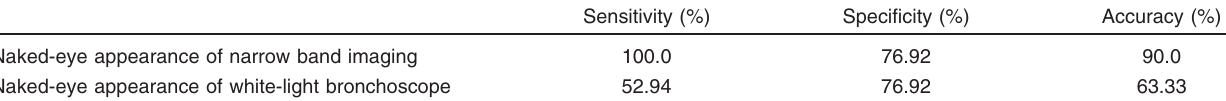
Table 7 Sensitivity, specificity, and accuracy of narrow band imaging and white-light bronchoscope according to the histopathological diagnosis